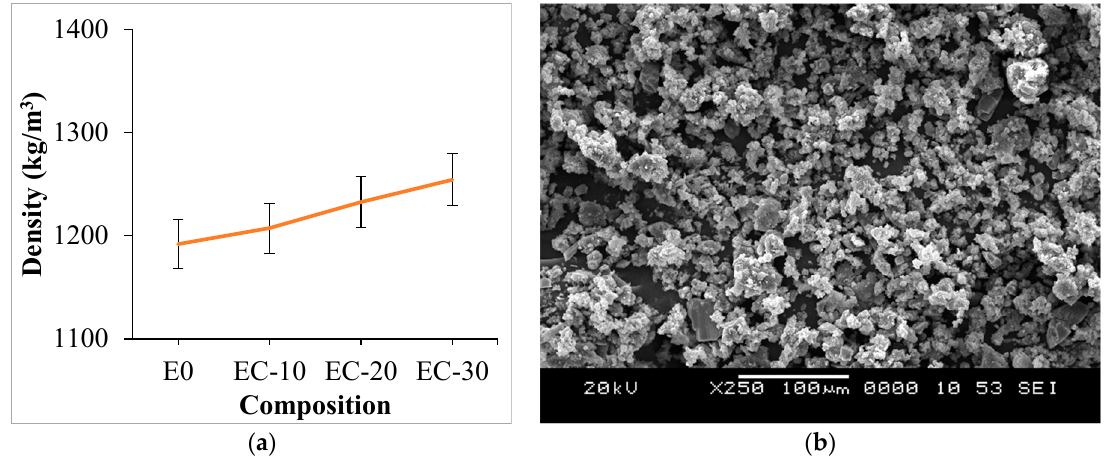
Figure 3. ( a ) Density of the composites and ( b ) Micrograph of crump rubber particles.